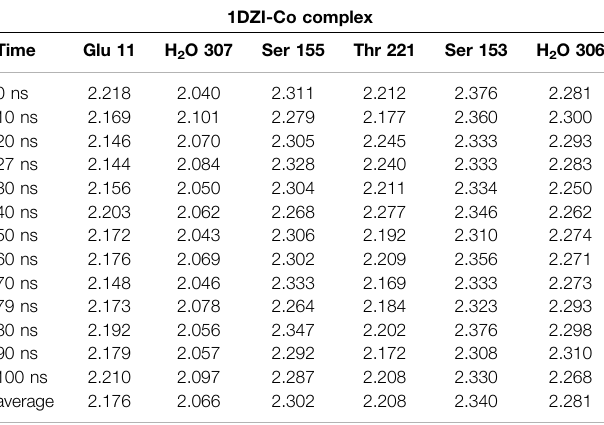
TABLE 4 | MD-Simulation of 1DZI (Emsley et al., 2000) with cobalt-complex in